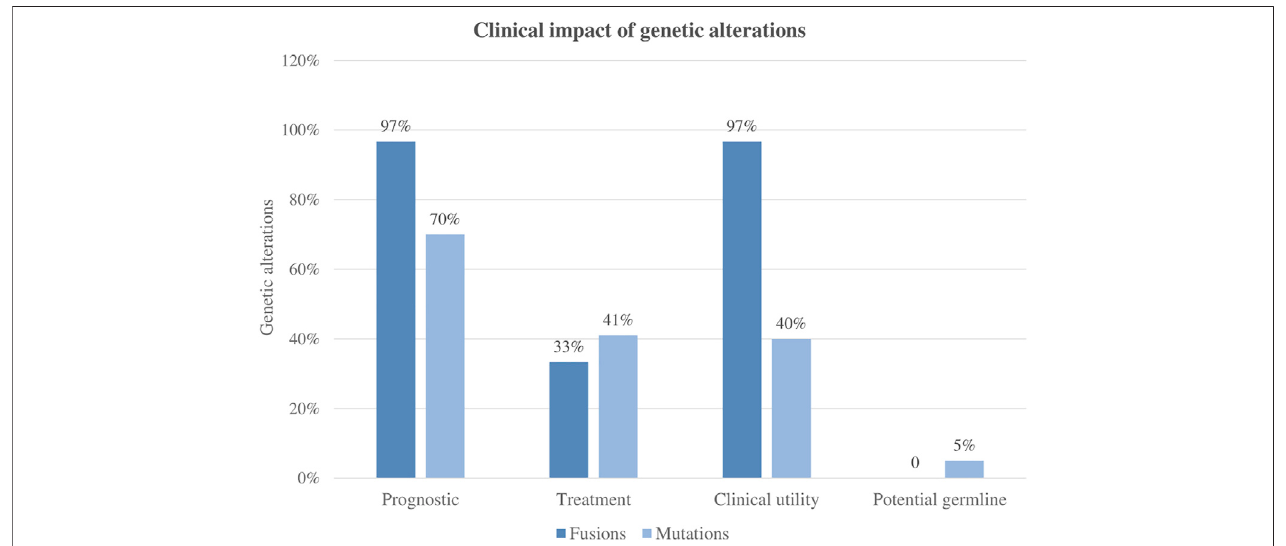
FIGURE 5 | Clinical impact of panel sequencing regarding different genetic alterations.